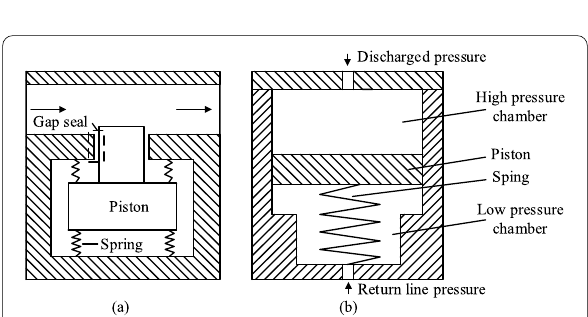
Figure 11 Pulsation attenuators based on mass-spring vibration system: a hydraulic spring, b mechanical spring